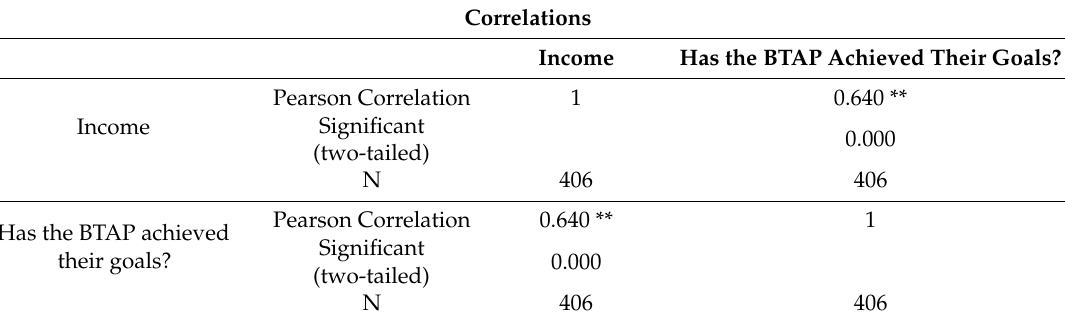
Table A6. Income correlations results.